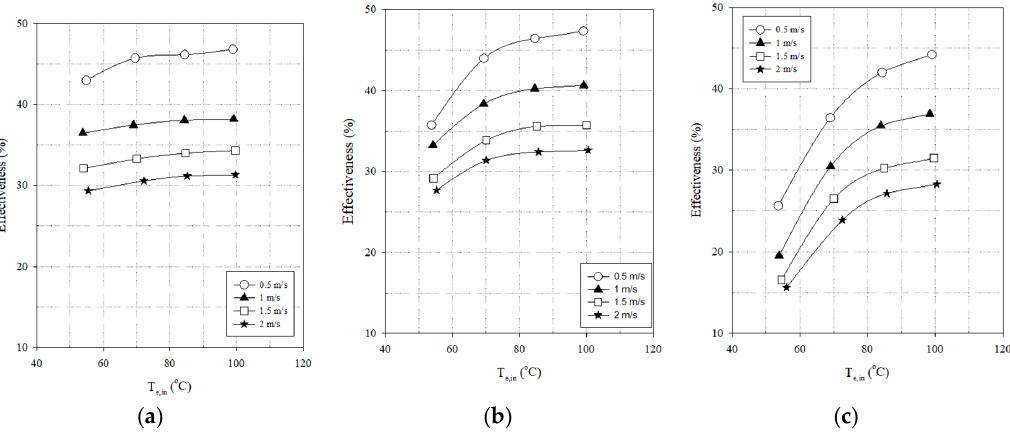
Figure 8. The effectiveness of the heat exchangers possessing a ( a ) HFE-7000-charged PHP, ( b ) water-charged PHP, and ( c ) HFE-7000-charged PHP without degassing, versus the evaporator temperature with filling ratio of 35% at airflow velocity ranging from 0.5 to 2.0